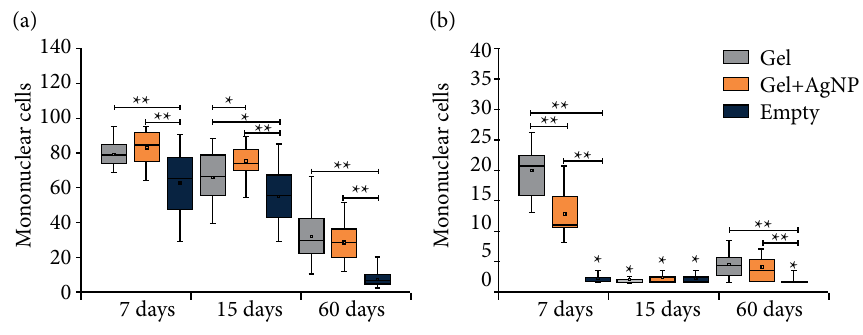
Figure 5 - Box-plot graphs showing (a) mononuclear cells and (b) polymorphonuclear cells quantified in the photomicrographs (eight images were made at 40x magnification, for each slide), at periods of seven, 15, and 60